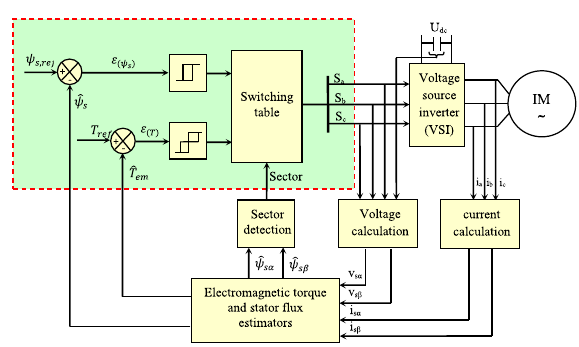
Fig. 1 Synoptic schema of DTC control of the Figure 7: Simplified schematic of a classic DTC drive induction machine (El Ouanjli et al., 2019a)